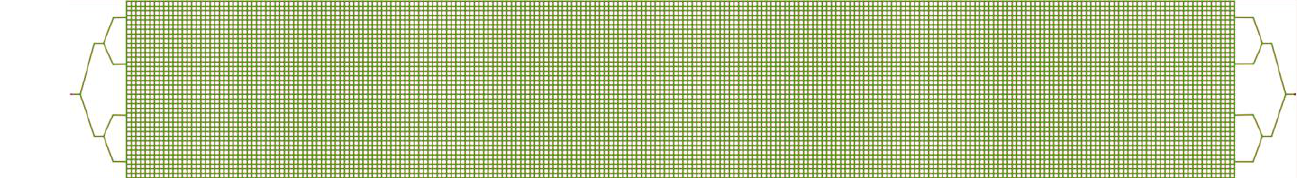
Figure 11. Pressure drop depending on the volumetric flow rate: channel with a pore diameter of